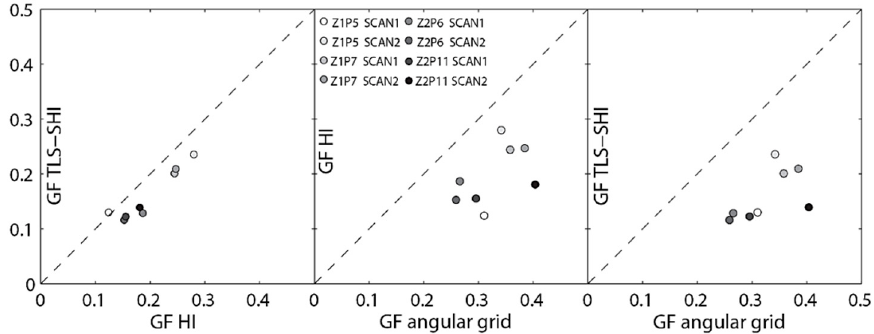
Figure 11. GF comparison between HI and TLS-SHI ( a ), angular grid and HI ( b ), and angular grid and TLS-SHI (c).